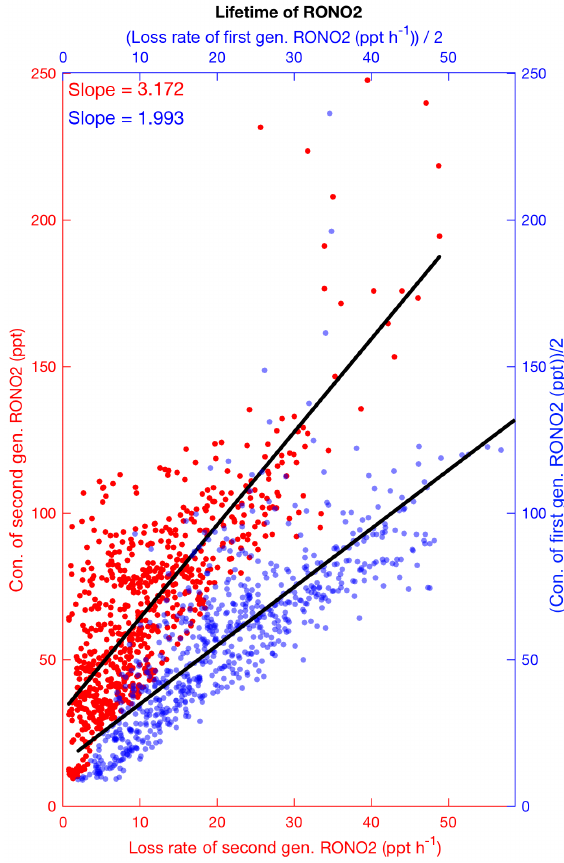
Figure 9. The simulated concentrations of first (blue) and second (red) generation organic nitrates versus their loss rates during day- time at SOAS. Slopes of the linear fit give their lifetimes. The con- centrations and loss rates of first-generation nitrates are divided by 2.